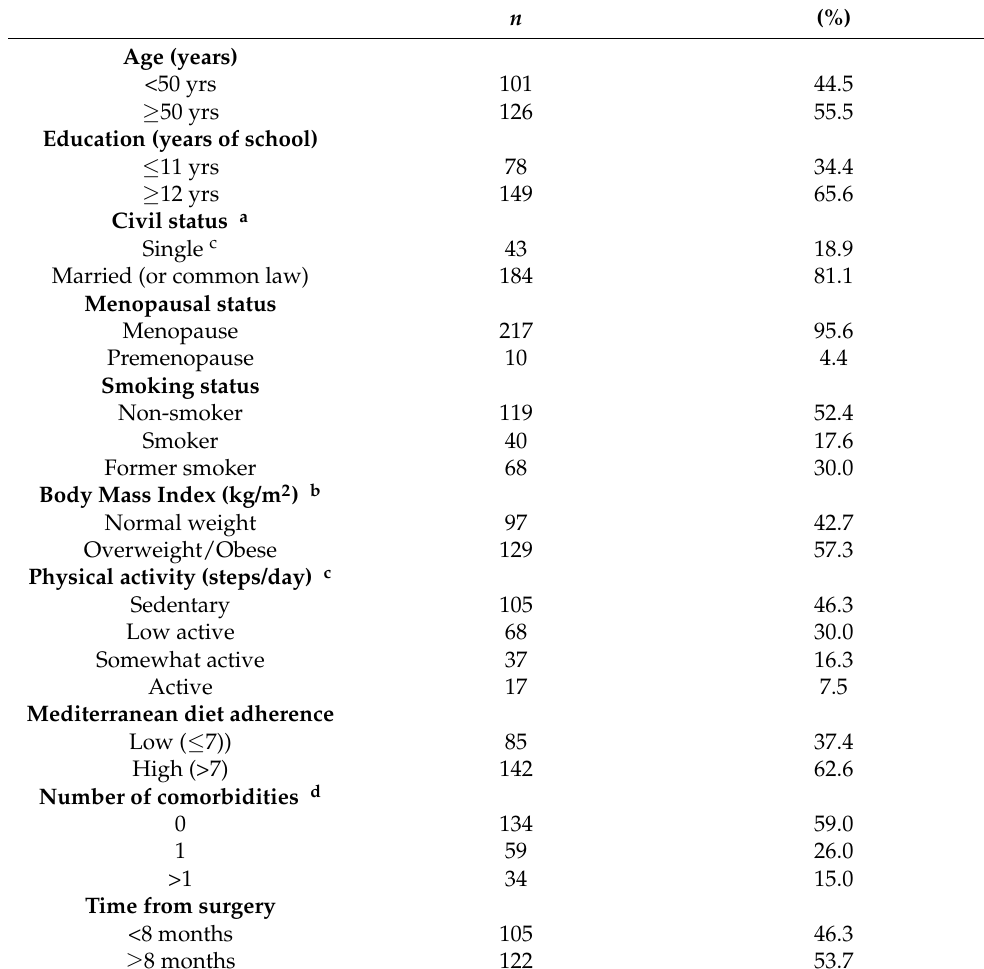
Table 1. Baseline characteristics of the participants ( n =